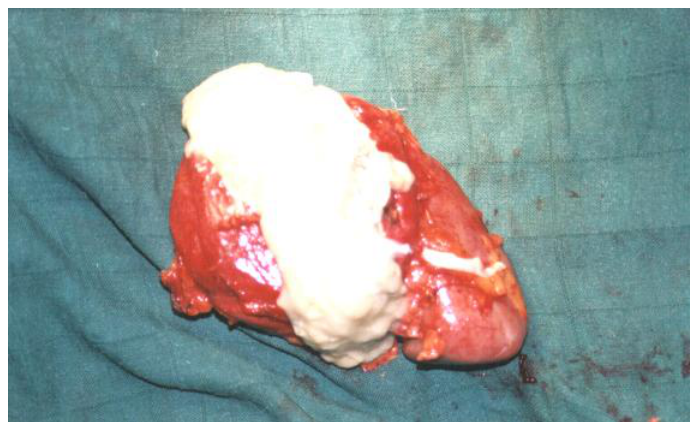
FIGURE 2. Macroscopic aspect: presence of whitish gelatinous infected substance at the opening of the